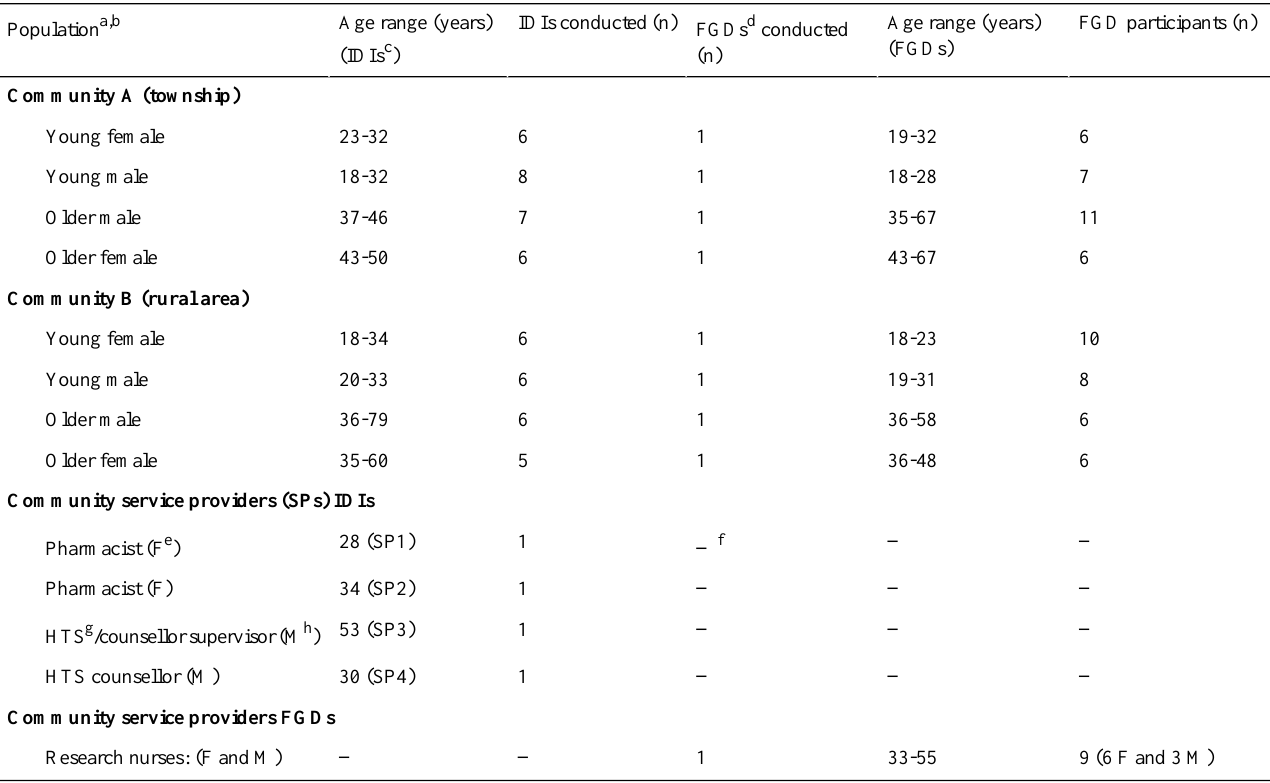
Table 1. Participant demographics and data collection